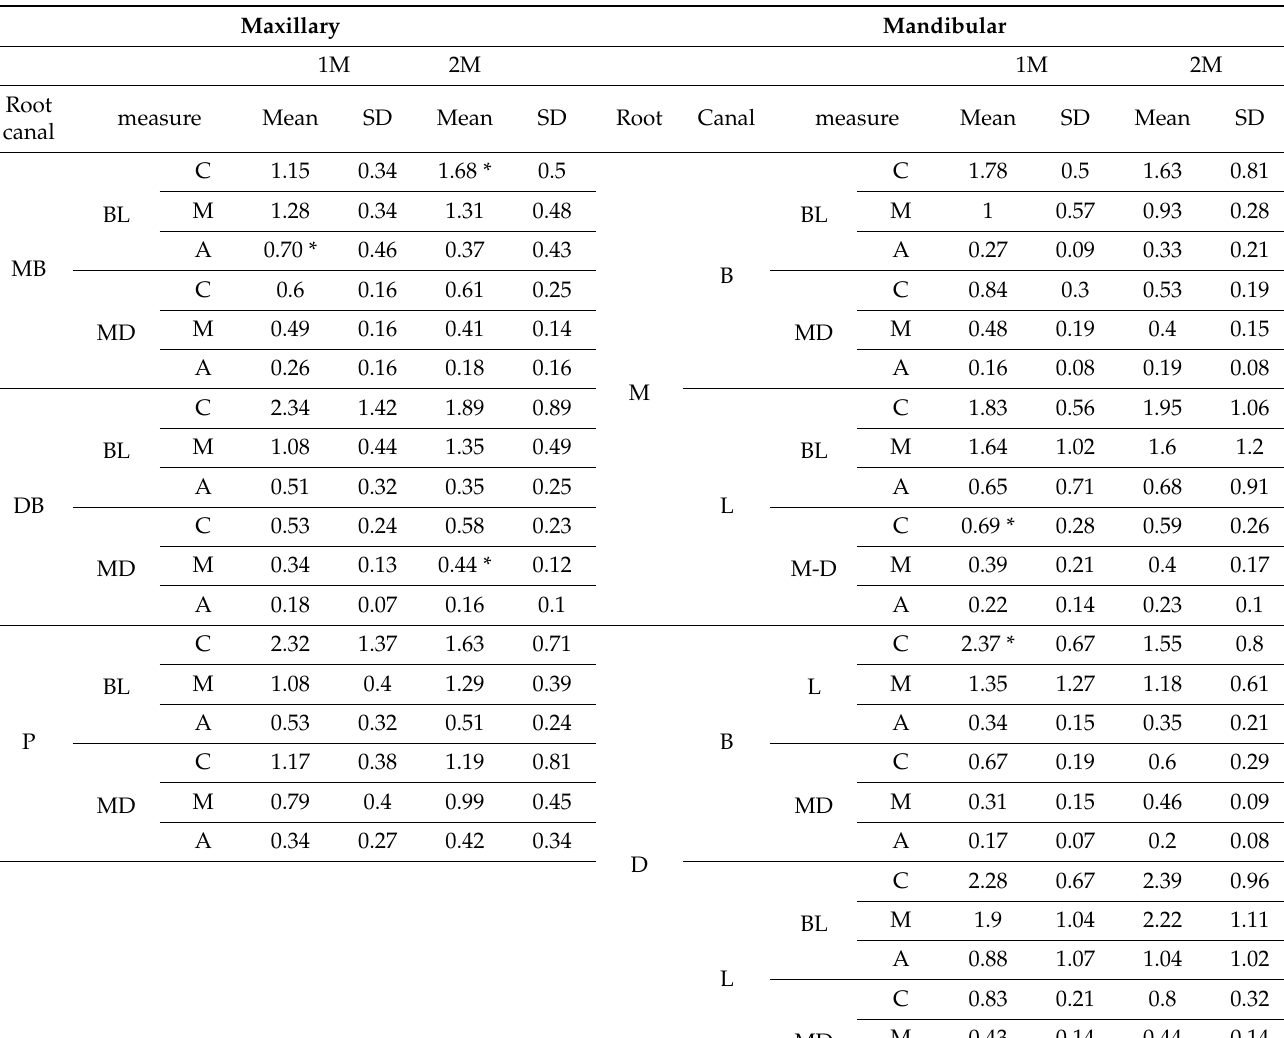
Table 4. Diameter measurement